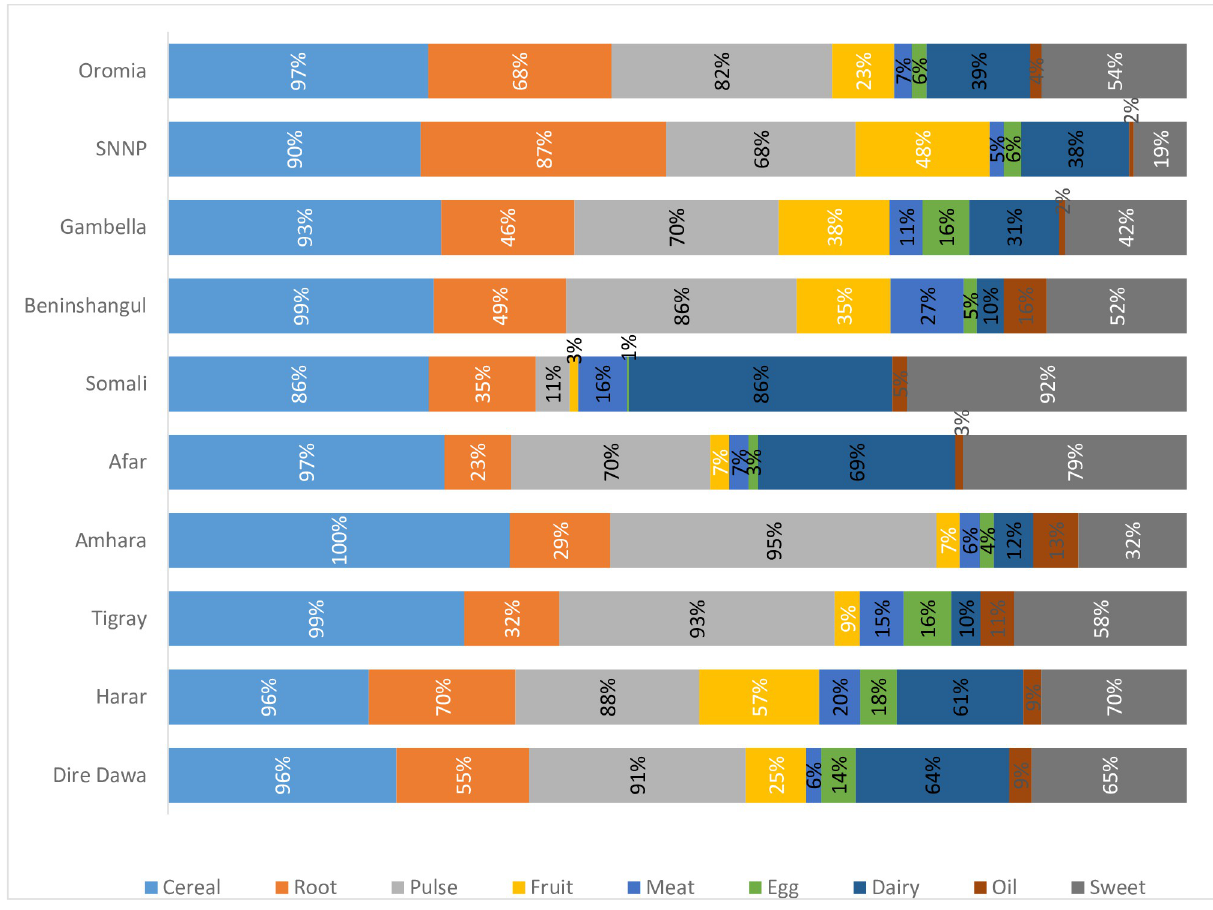
Fig 1. Food groups consumed across regions in